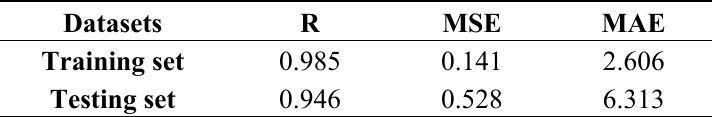
Table 3. Statistical parameters.